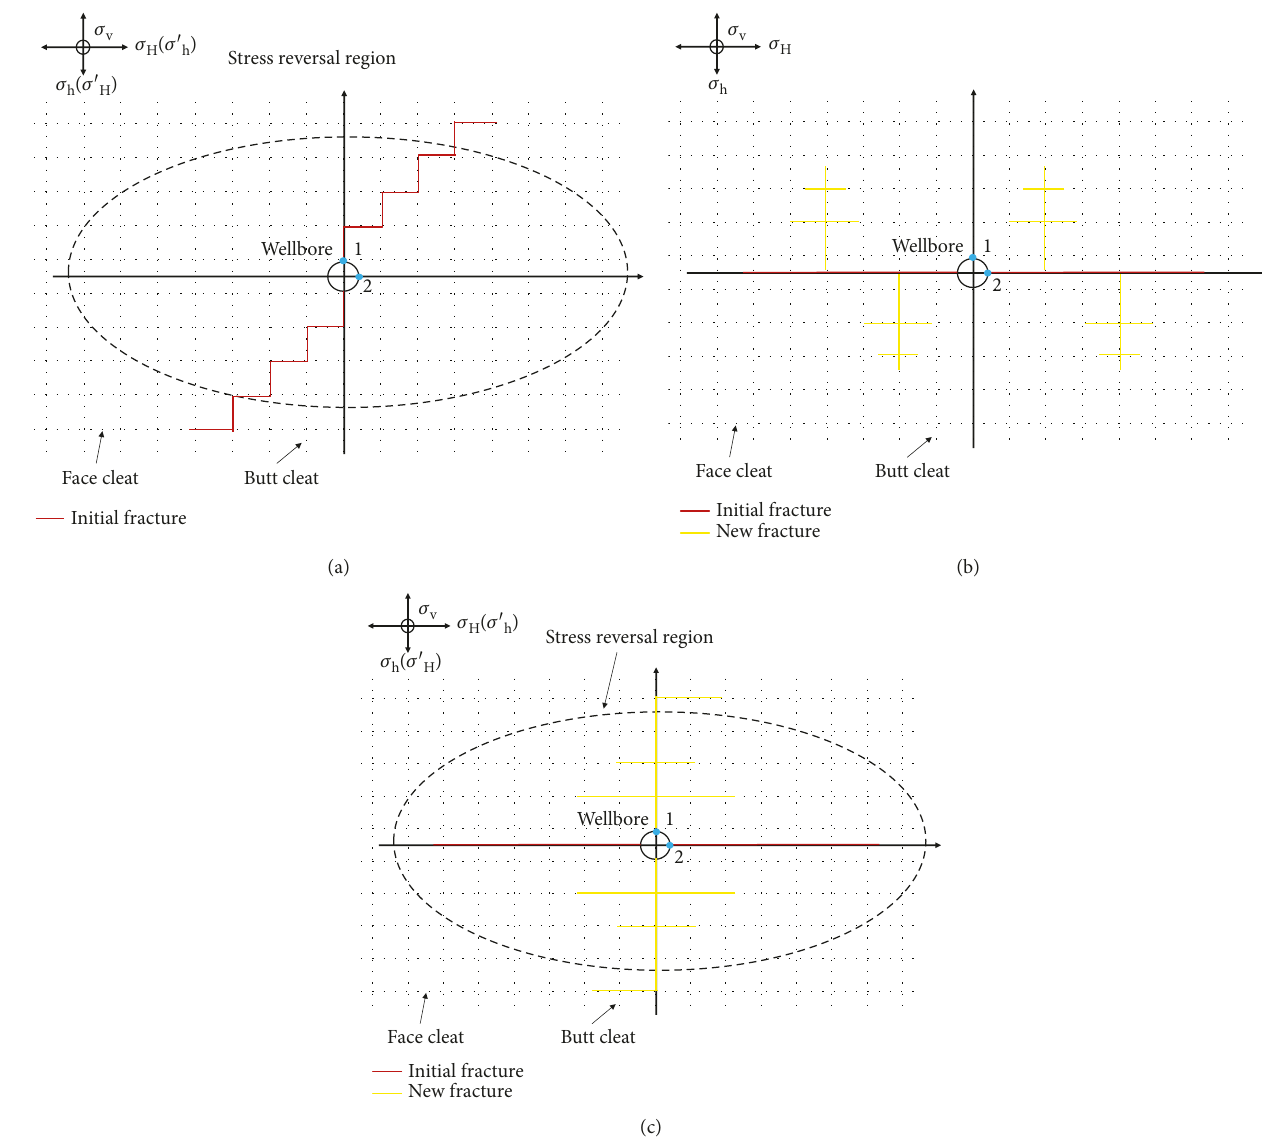
– 2MPa), and no new HFs were h was small (0